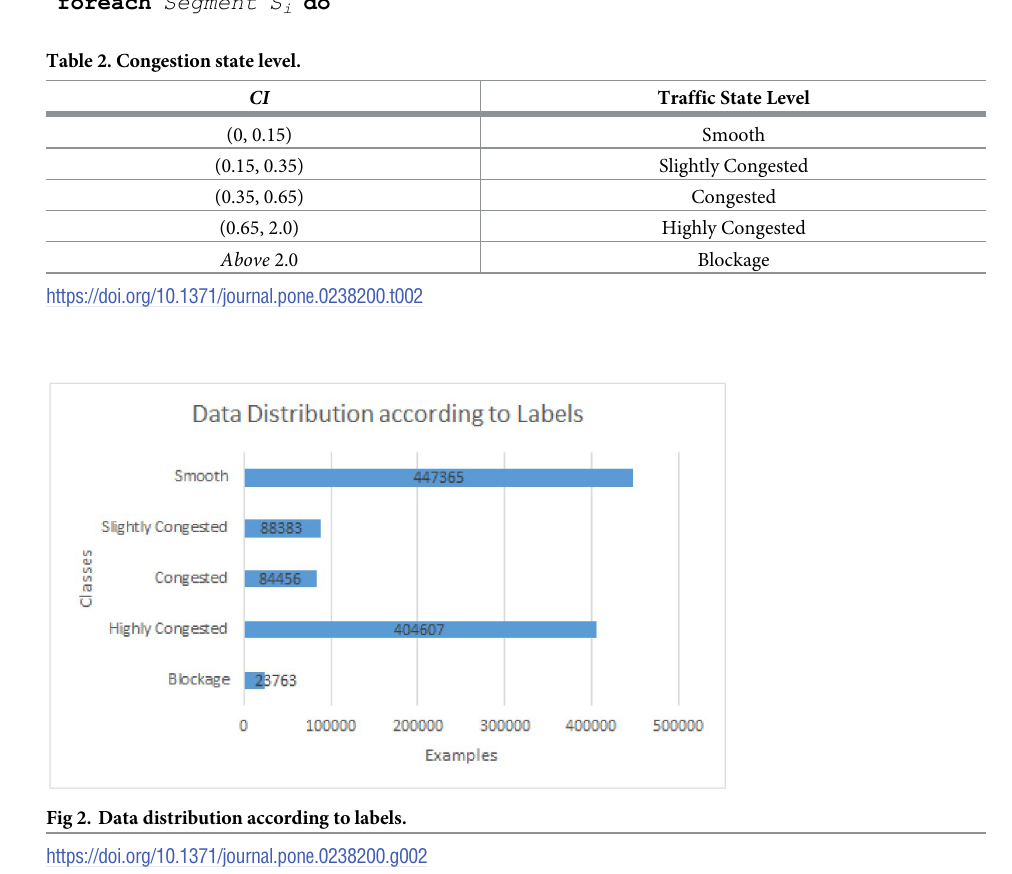
Algorithm 1 : Segmentation normalization of CI